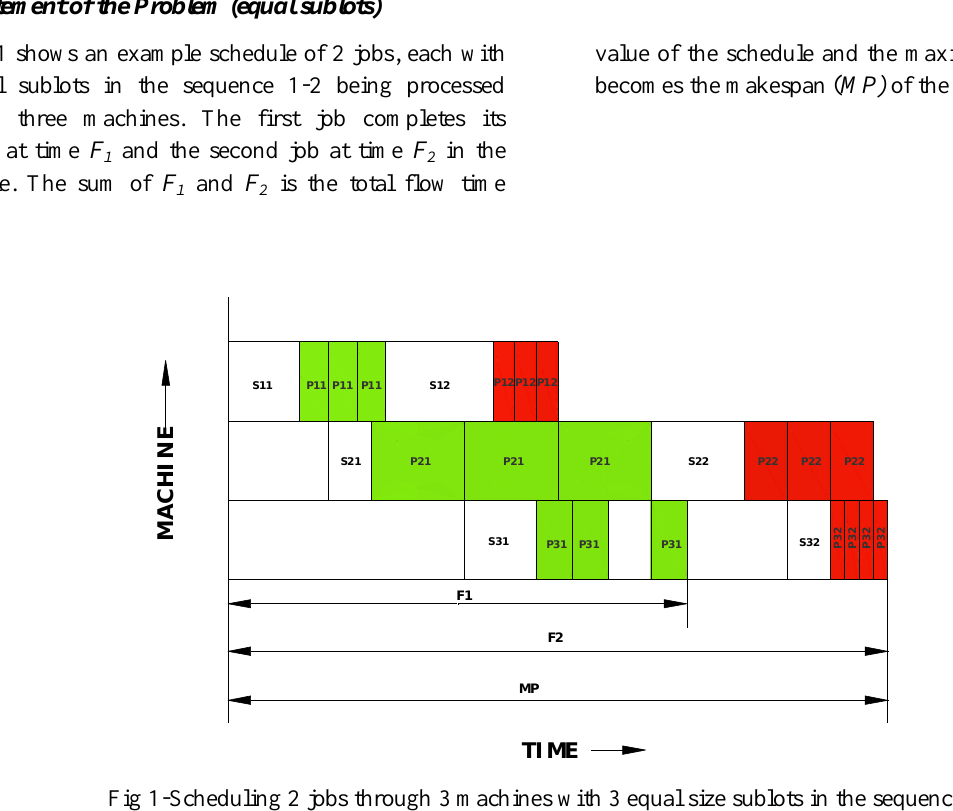
Fig 1-Scheduling 2 jobs through 3 machines with 3 equal size sublots in the sequence